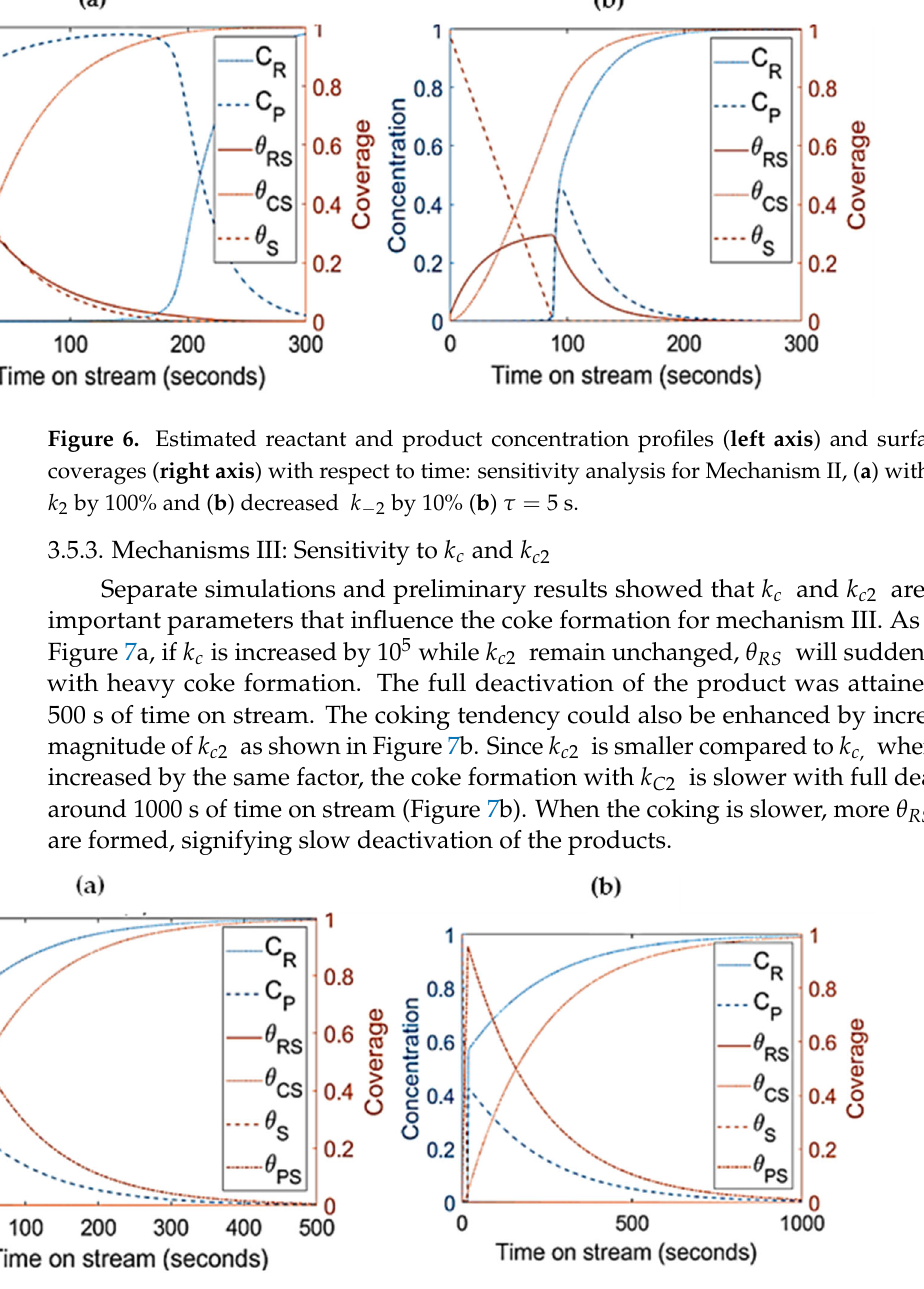
Figure 7. Estimated reactant and product concentration pro fi les ( left axis ) and surface species cov- erages ( right axis ) with respect to time: sensitivity analysis for Mechanism III, ( a ) with increased 𝑘 (cid:3004) by 10 (cid:2879)(cid:2873) and 𝑘 (cid:3004)(cid:2870) unchanged ( b ) with increased 𝑘 (cid:3004)(cid:2870) by 10 (cid:2879)(cid:2873) and 𝑘 (cid:3004)